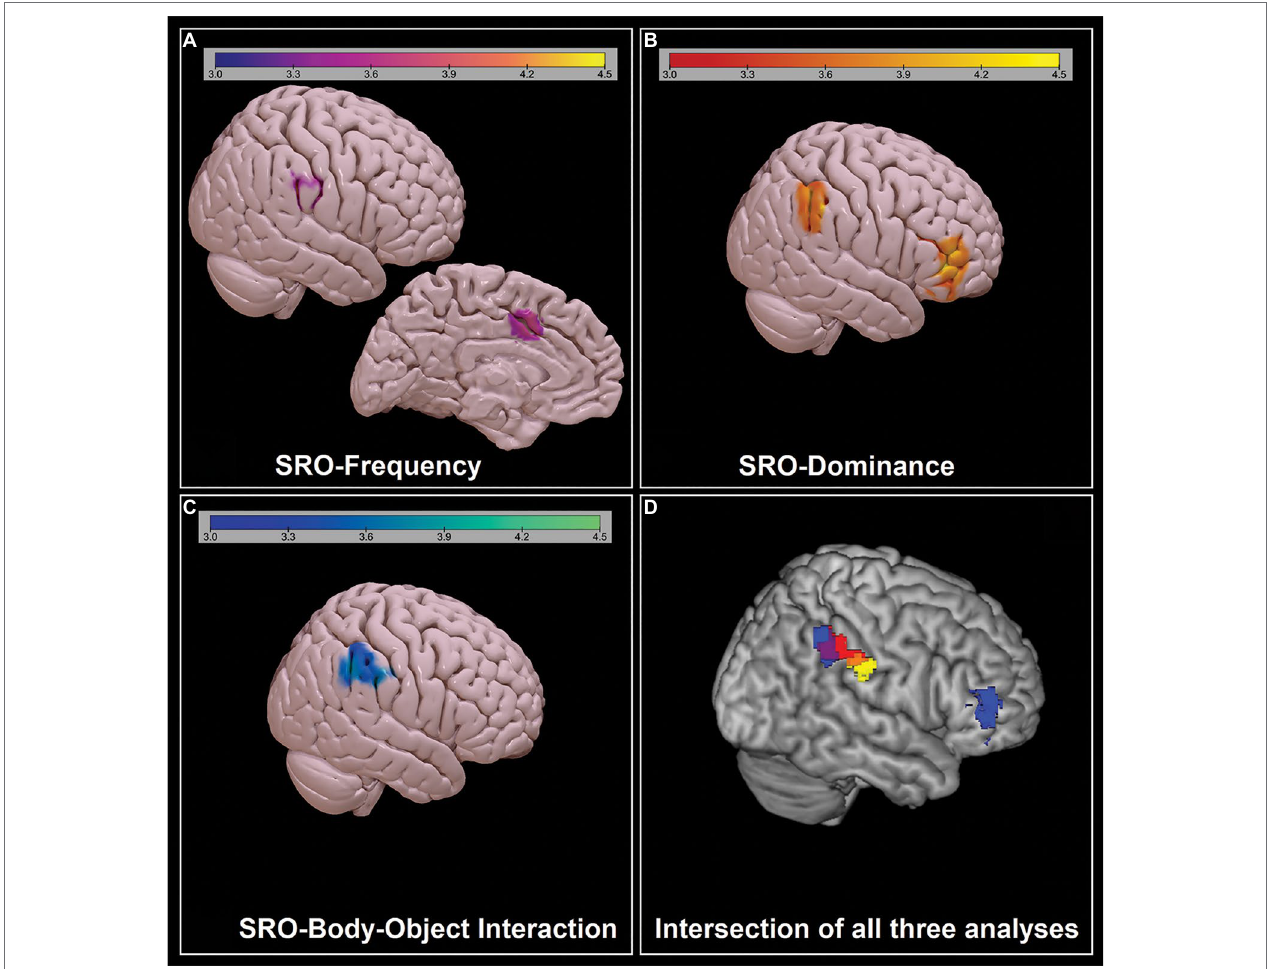
FIGURE 4 | Significant negative associations between SRO-semantic feature z -converted correlation coefficients and DMN expression, as emerging from the first set of inferential models: (A) ‘SRO-frequency’; (B) : ‘SRO-dominance’; (C) ‘SRO-body-object interaction’. The strength of the association (expressed in z -scores) is reported at the top. (D) Intersection of the three maps: For a better visualisation, the clusters are shown at a depth of 8 voxels.